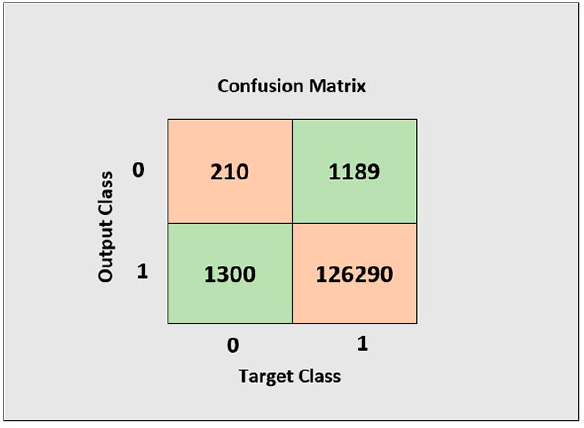
Figure 8. Confusion matrix of the ECG1 classified beats.